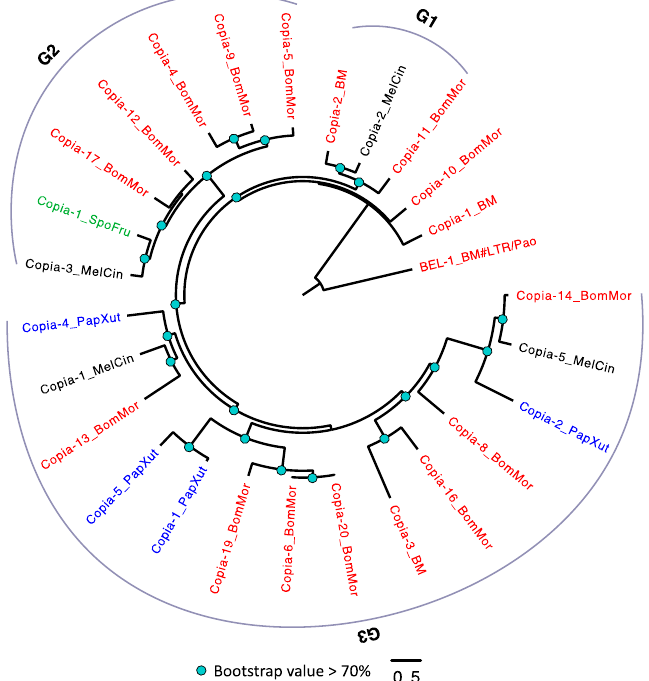
Figure 3. The phylogeny of Copia in Lepidoptera . The Copia were arbitrarily divided into three groups (G1–3). TEs with BM (annotated in Repbase) or BomMor (annotated in this study) suffixes are from B. mori (red name); TEs with PapXut, MelCin, and SpoFru suffixes are from P. xuthus (blue name), M. cinxia (black name), and S. frugiperda (green name). Only nodes with bootstrap value not lower than 70% were indicated. BEL-1_BM is the outgroup.